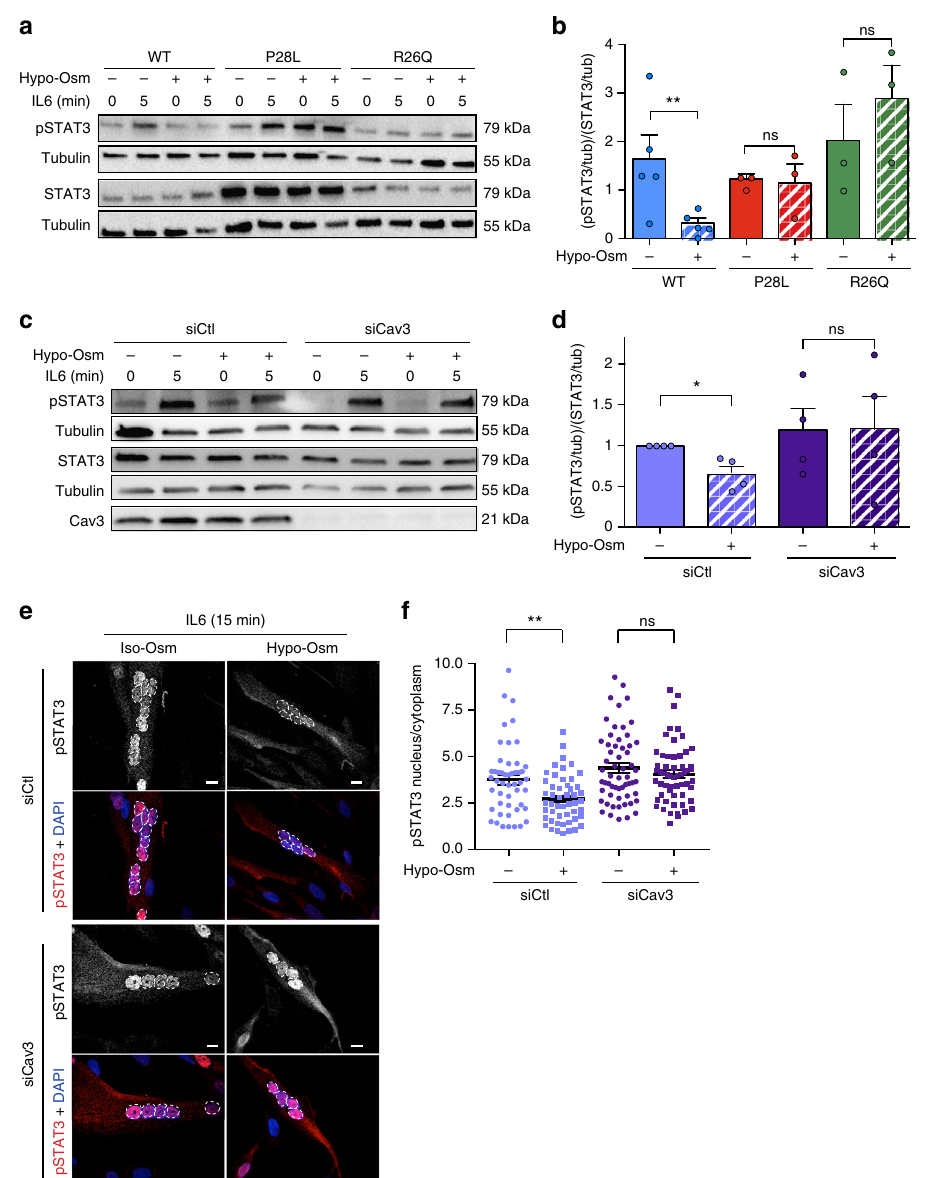
Fig. 4 IL6/STAT3 mechanosignaling is impaired in Cav3 P28L and R26Q myotubes. a , c Immunoblot analysis of pSTAT3 and STAT3 levels in WT, Cav3 P28L, and Cav3 R26Q myotubes ( a ), and WT ctl (siCtl) or Cav3-depleted (siCav3) myotubes ( c ) subjected or not to a 75 mOsm hypo-osmotic shock (Hypo-Osm) for 10 min, followed by stimulation or not with 10 ng mL − 1 IL6 for 5 min. Tubulin serves as loading control. b , d Quanti fi cation of STAT3 activation in a and c respectively, corresponding to the ratio pSTAT3 on STAT3 total level after normalization to tubulin level. e Confocal microscopy of immuno fl uorescent pSTAT3 in WT (siCtl) and Cav3-depleted (siCav3) myotubes subjected or not to a 75 mOsm hypo-osmotic shock (Hypo-Osm) for 5 min, followed by stimulation or not with 10 ng mL − 1 IL6 for 15 min. White dashed lines outline nucleus boundaries. f Quanti fi cation of pSTAT3 nuclear translocation in e corresponding to the mean intensity of the nuclei/cytoplasm pSTAT3 ratio. e Scale bar = 10 µ m. Reproducibility of experiments: a , c , e Representative data. b Quanti fi cation was done on 5 and 3 independent experiments for WT and mutants, respectively. d Quanti fi cation was done on 4 independent experiments. f Quanti fi cation was done on 3 independent experiments (Iso-Osm: siCtl n = 49 cells, siCav3 n = 50 cells; Hypo-Osm: siCtl n = 58 cells, siCav3 n = 57 cells). Mean value ± SEM. b , d Statistical analysis with two-tailed paired t test. d Statistical analysis with a one-way ANOVA * P